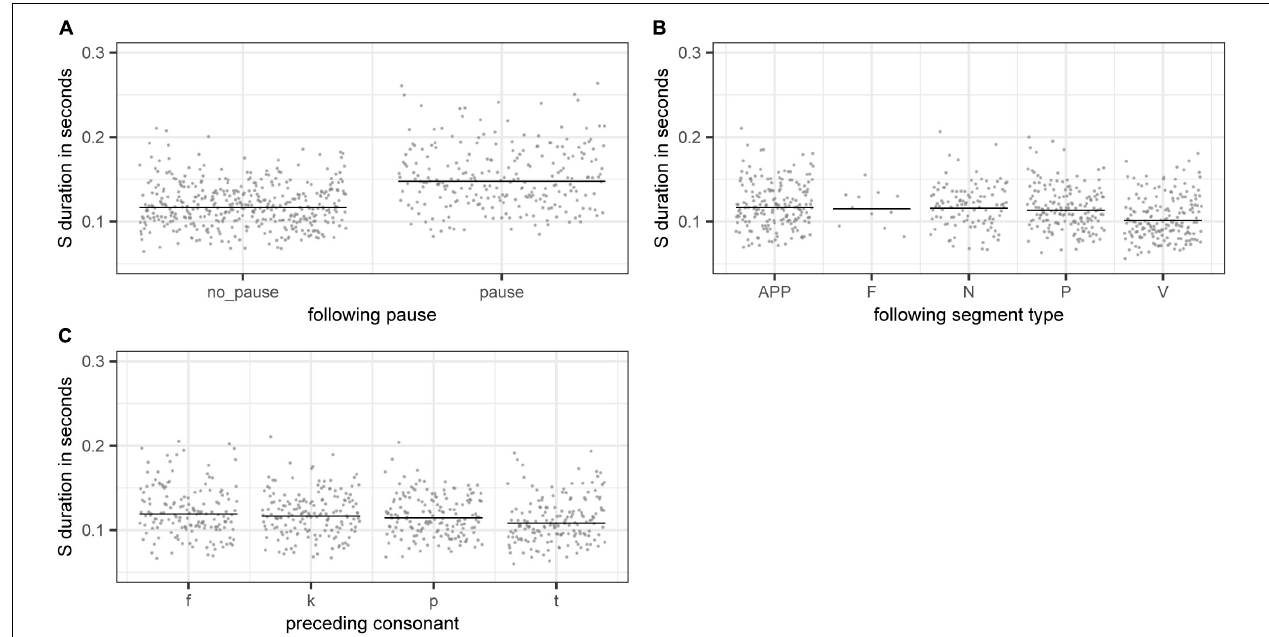
FIGURE 4 | Partial effects of the categorical variables included in the final “LDL measures and AFFIX” model, fitted to the log-transformed values of duration of S. (A) PAUSE B IN (B) FOL T YPE (C) PRE C.